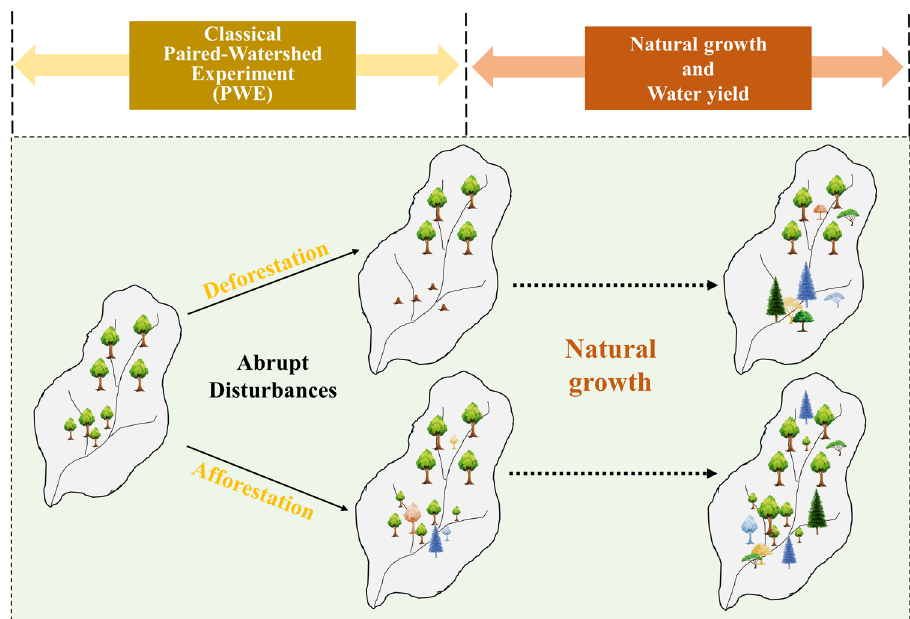
Fig. 4 Conceptual diagram of the approaches used to examine forest change impacts on water yield in this study. The classical paired-watershed experiments (PWE) focus on the effect of the abrupt forest change on water yields, whereas the effects of natural growth on water yields are highlighted in this